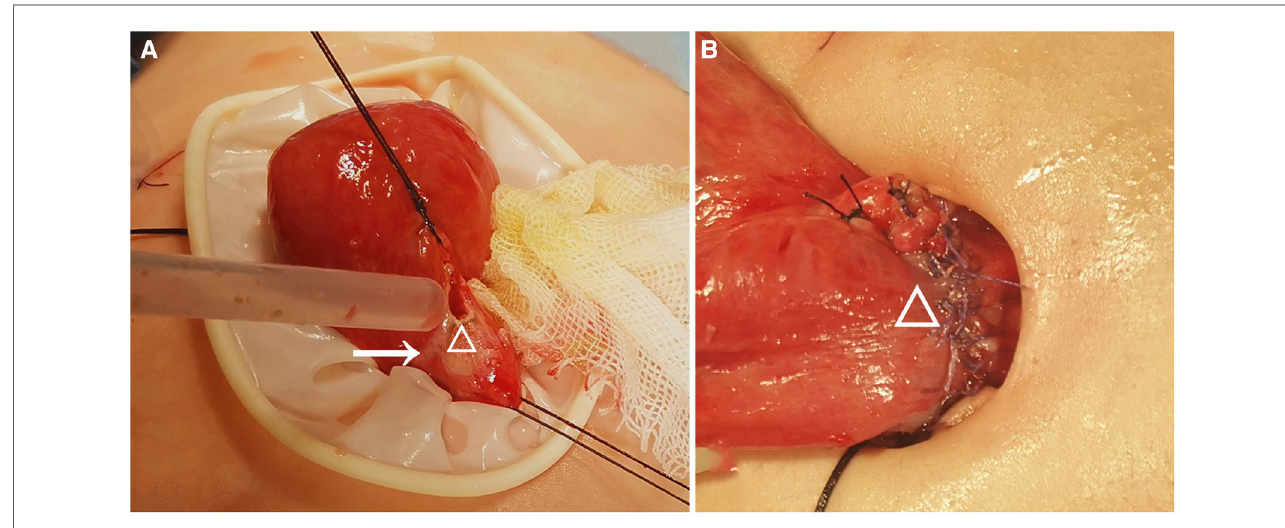
Table 1 . The male-to-female ratio was 2.29:1. The BMI was